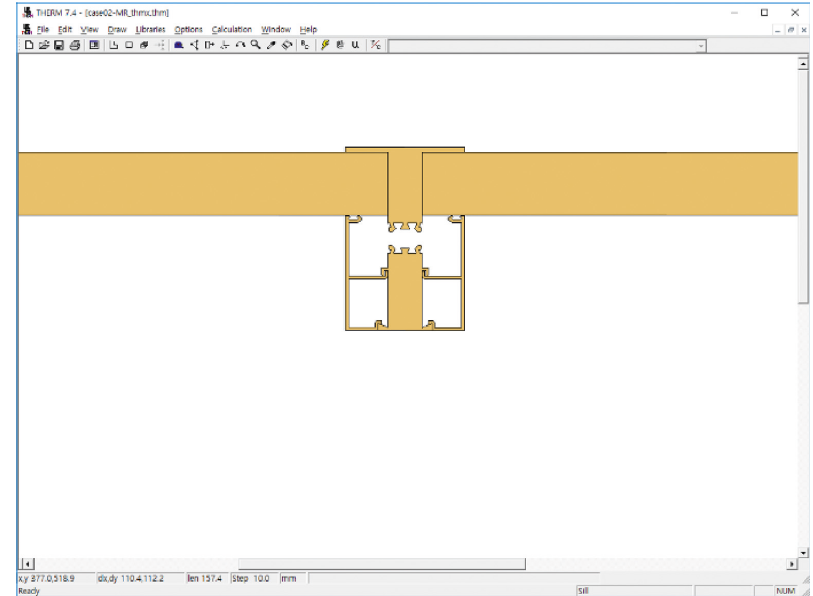
Figure 14: THERM input result (meeting rail) of test case 2.